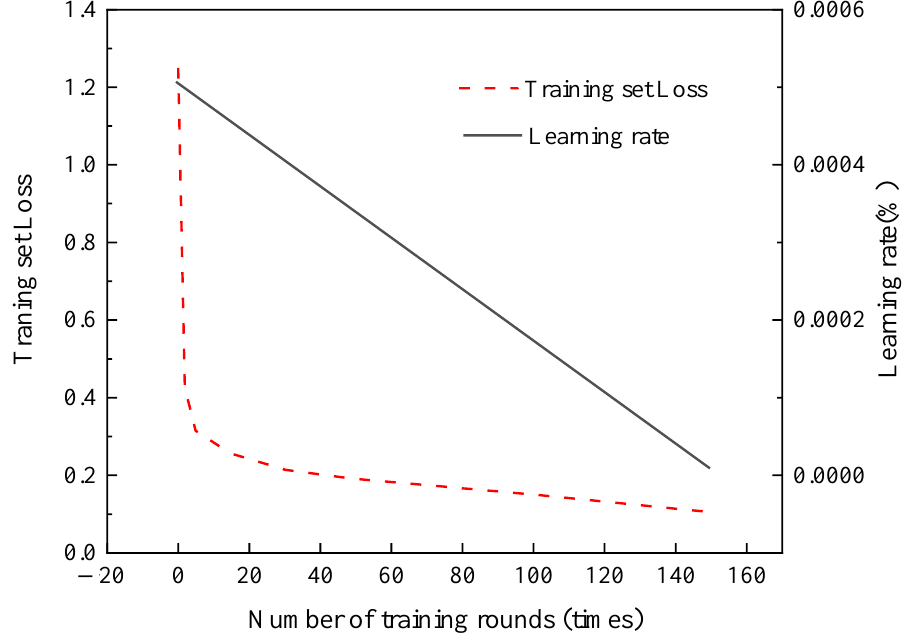
Figure 13. Curve graph of the training set Loss and the learning rate and the number of training epochs.